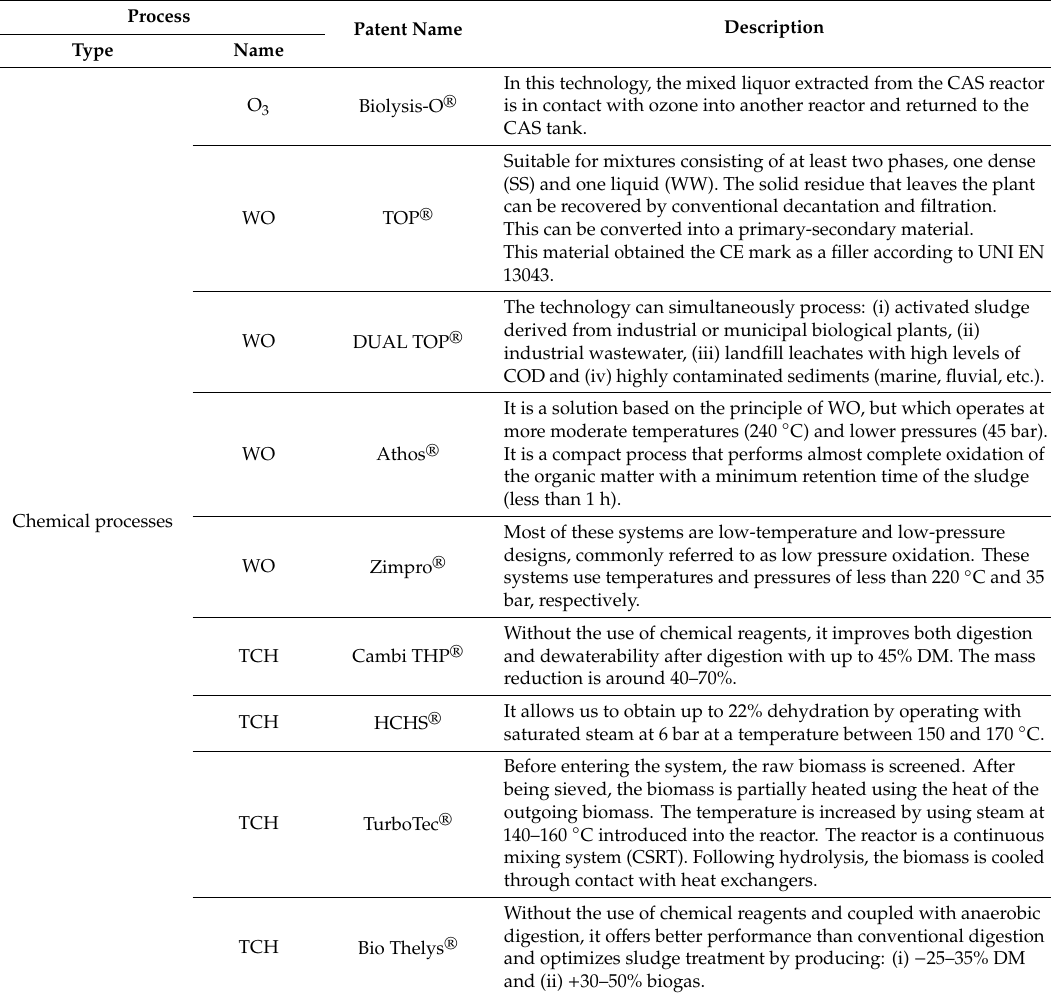
Table 6. List of several patents, by way of example, available on the market. The presence of other patents not mentioned here is not